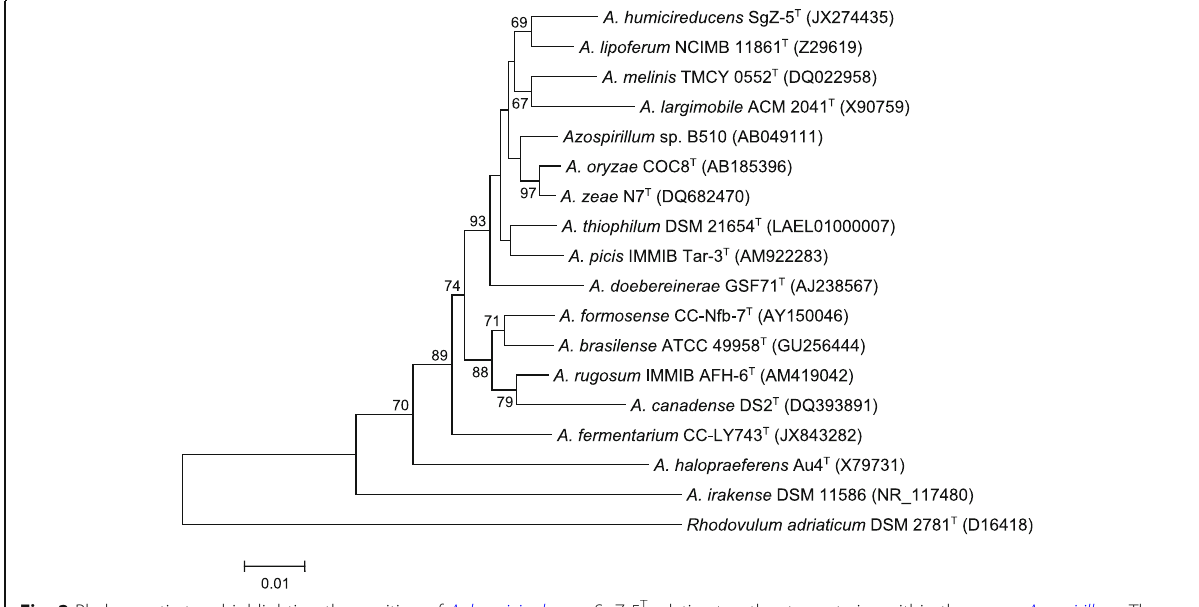
Fig. 2 Phylogenetic tree highlighting the position of A. humicireducens SgZ-5 T relative to other type strains within the genus Azospirillum . The strains and their corresponding GenBank accession numbers of 16S rRNA genes were indicated in parentheses. The sequences were aligned using Clustal W and the neighbor-joining tree was constructed based on kimura 2-paramenter distance model by using MEGA 5. Bootstrap values above 50 % were obtained from 1000 bootstrap replications. Bar , 0.01 substitutions per nucleotide position. Rhodovulum adriaticum DSM 2781 T was used as an outgroup